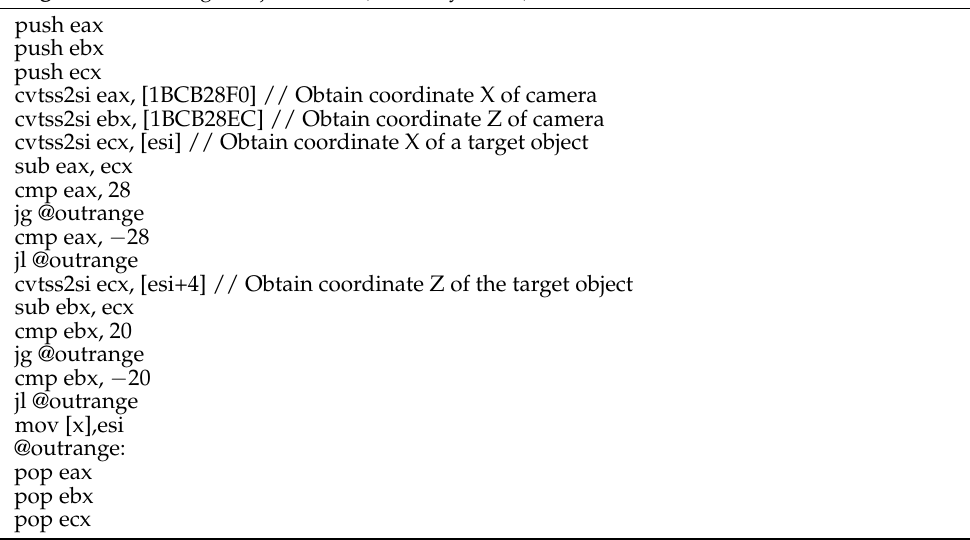
Algorithm A2: Target objects filter.